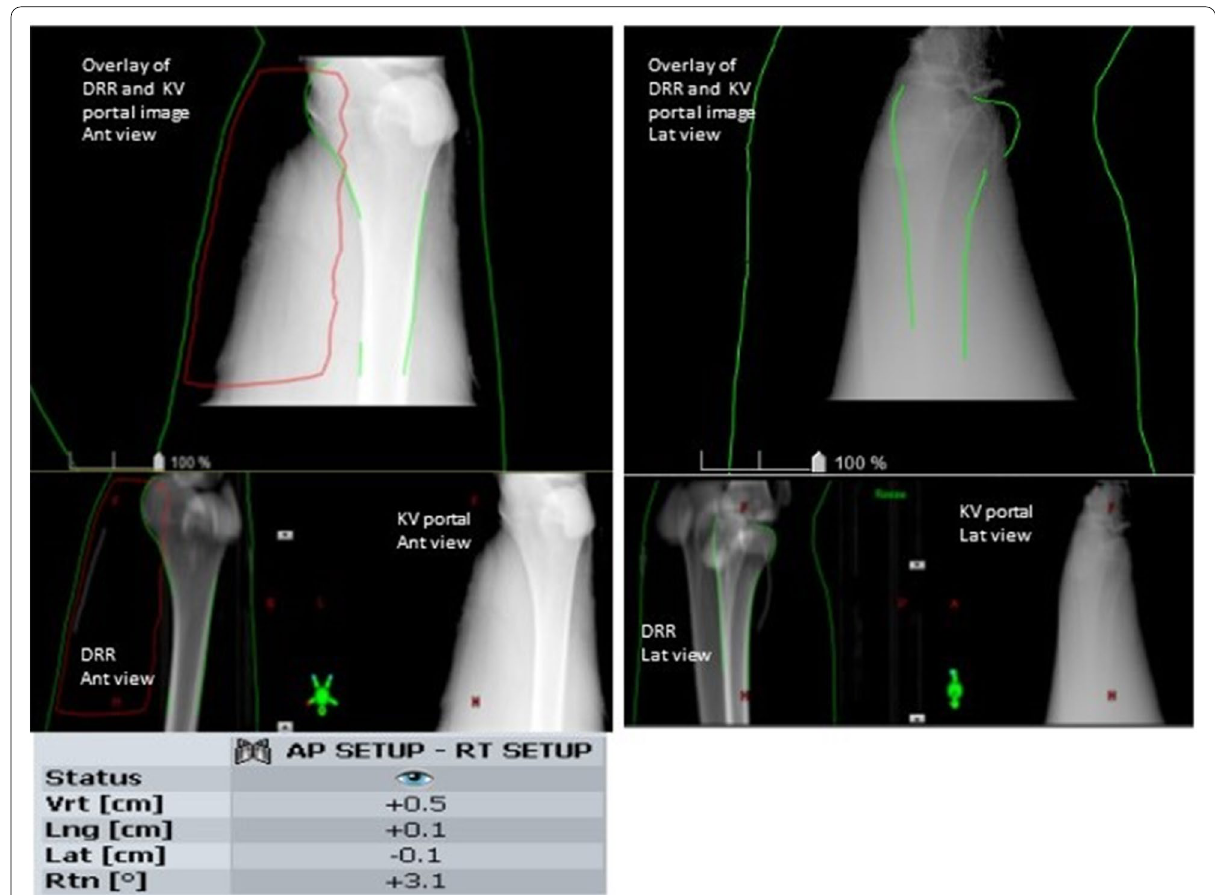
Fig. 3 Online KV portal image matching with DRR for a case of Vac‑Loc ™ fixation. The figure shows the overlay of the digitally reconstructed image (DRR) of CT simulation and the KV portal image taken during treatment for a patient immobilized using the Vac‑Loc ™ in the anterior and lateral views. Bony structure and body contour delineated on the DRR by green color was matched with KV portal images. The red color represents the PTV. The computerized system generated table showed the isocenter shifts measured in cm in Vrt (vertical), Lng (longitudinal), Lat (lateral) and